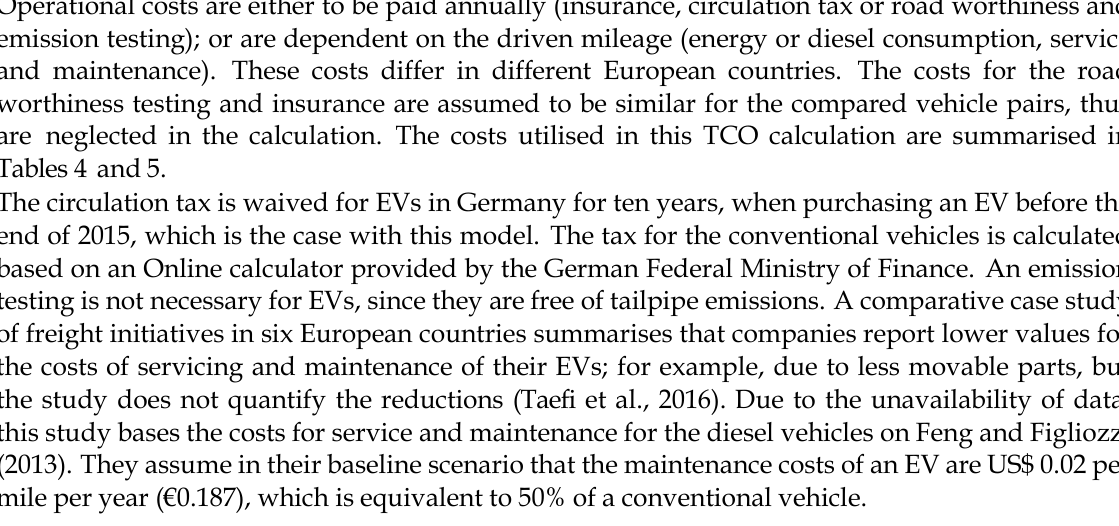
Table 4. Details of the costs for operation and maintenance Operational and maintenance costs p.a.